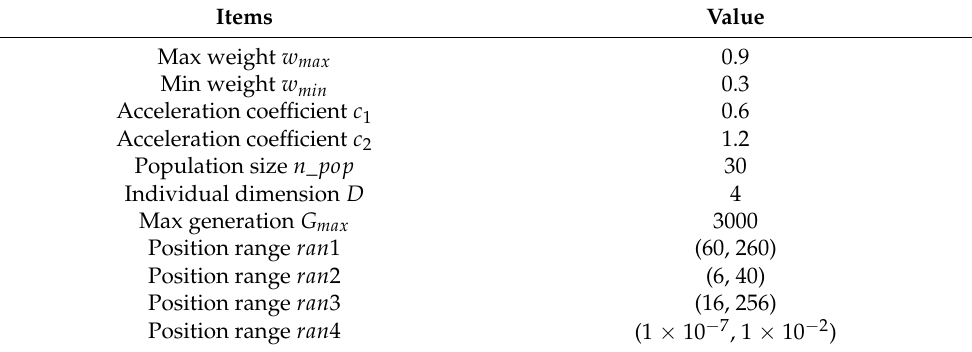
Table 4. Parameters of PSO.